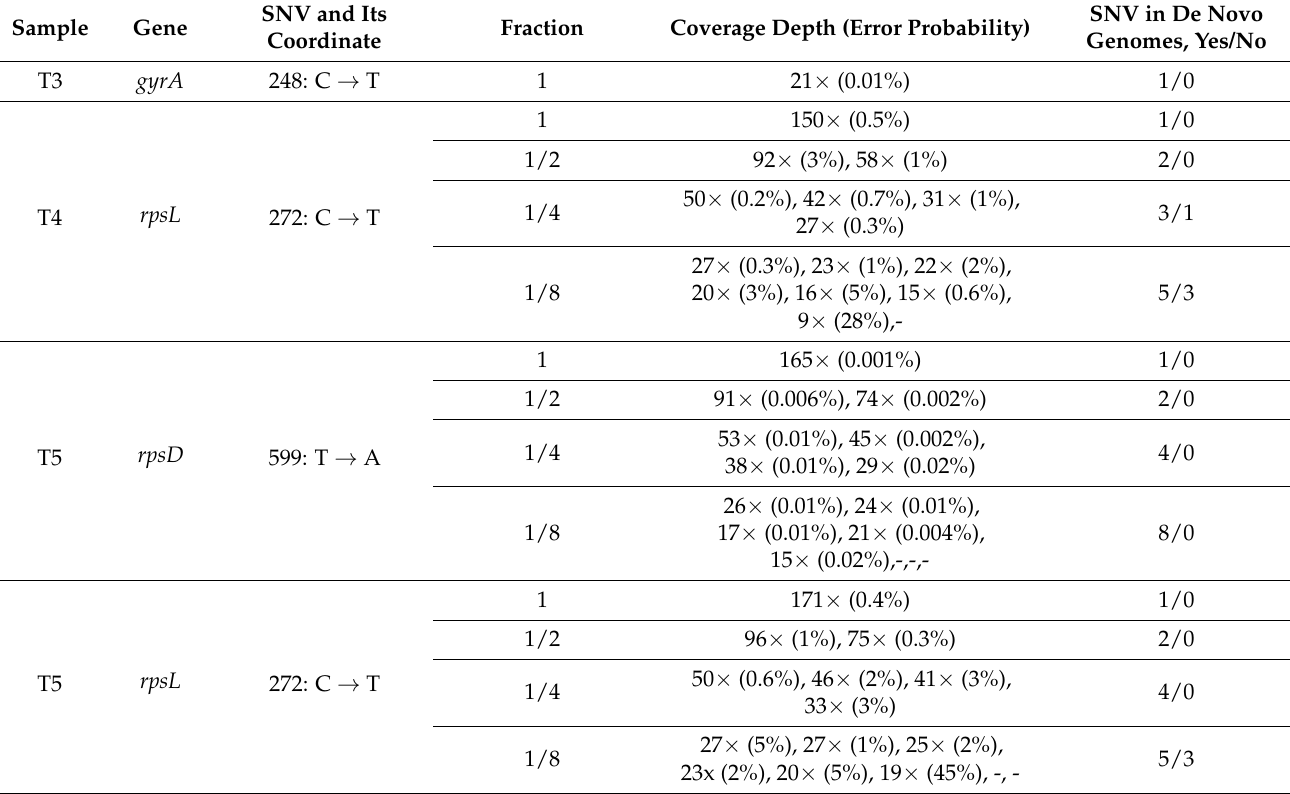
Table 2. SNVs in samples T3–T5. The probability of error is determined by the quality of the data in this position and the coverage depth during the analysis by the Medaka program [28]. The Fraction column shows the fraction of reads from the entire set utilized for analysis. The values of the coverage depth and error probability are separated by commas if several subsets of data were generated with a given fraction of the entire sample. “-” refers to samples in which no SNV was found. The last column presents data on SNVs detection in de novo assembled